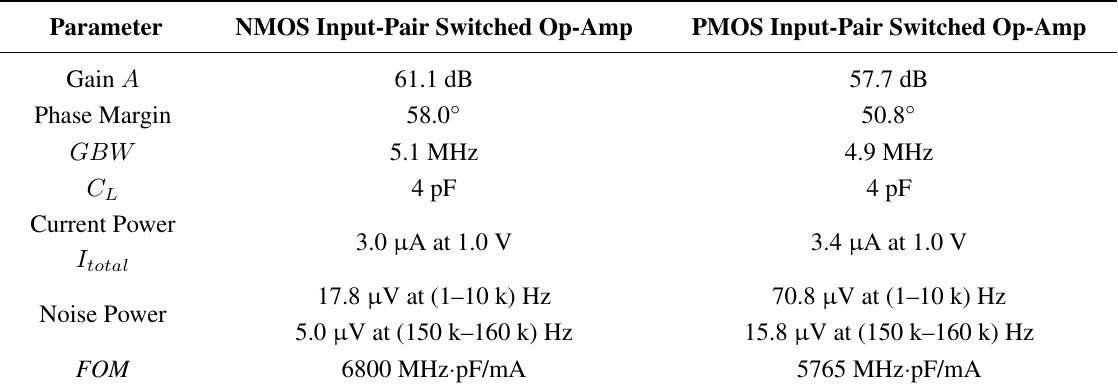
Table 2. Simulation results of the proposed switched